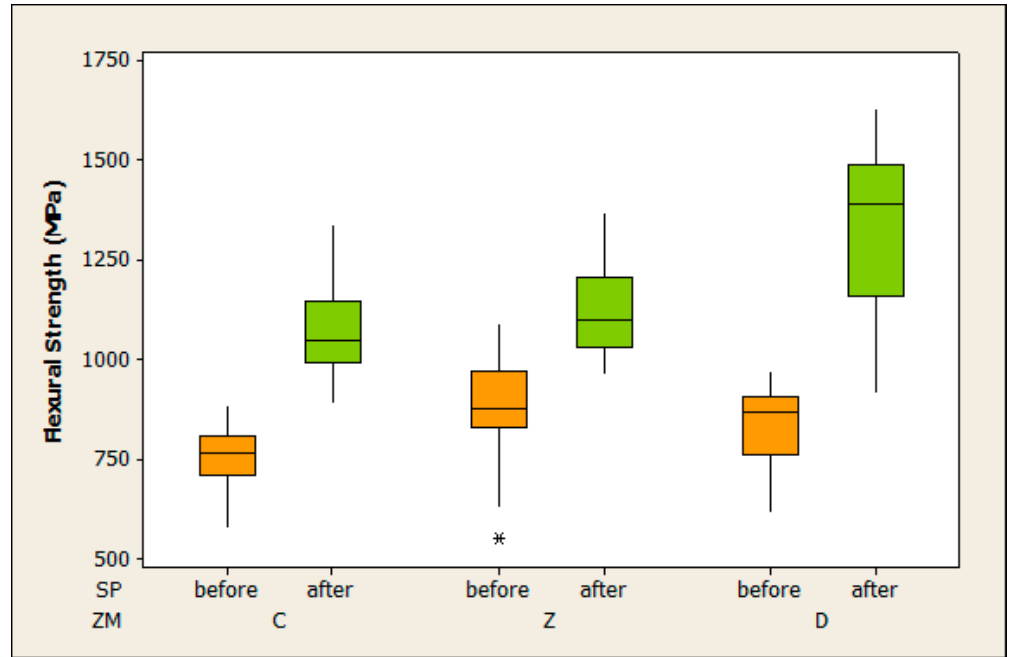
Figure 2. Boxplots for the biaxial flexural strength in each tested group G and ZM/SP levels.